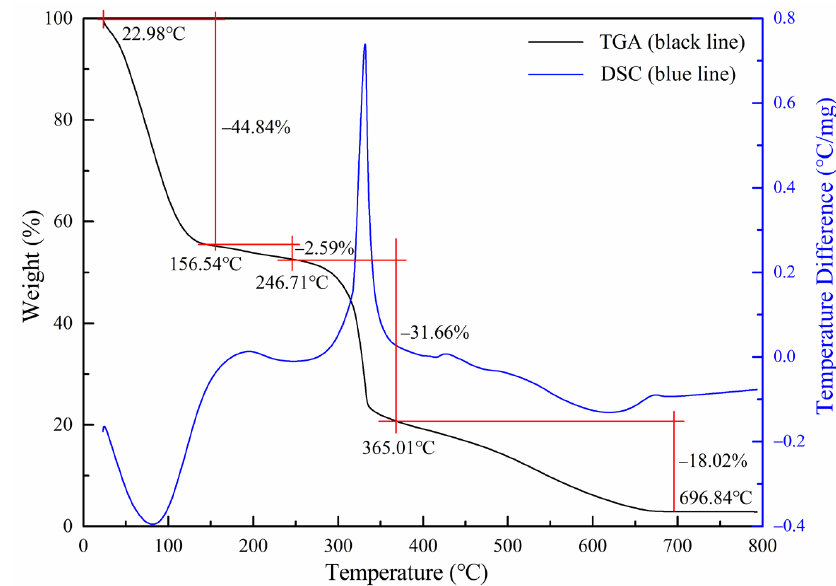
Figure 4. (Color online) The thermal decomposition data of 50% PEI solution.